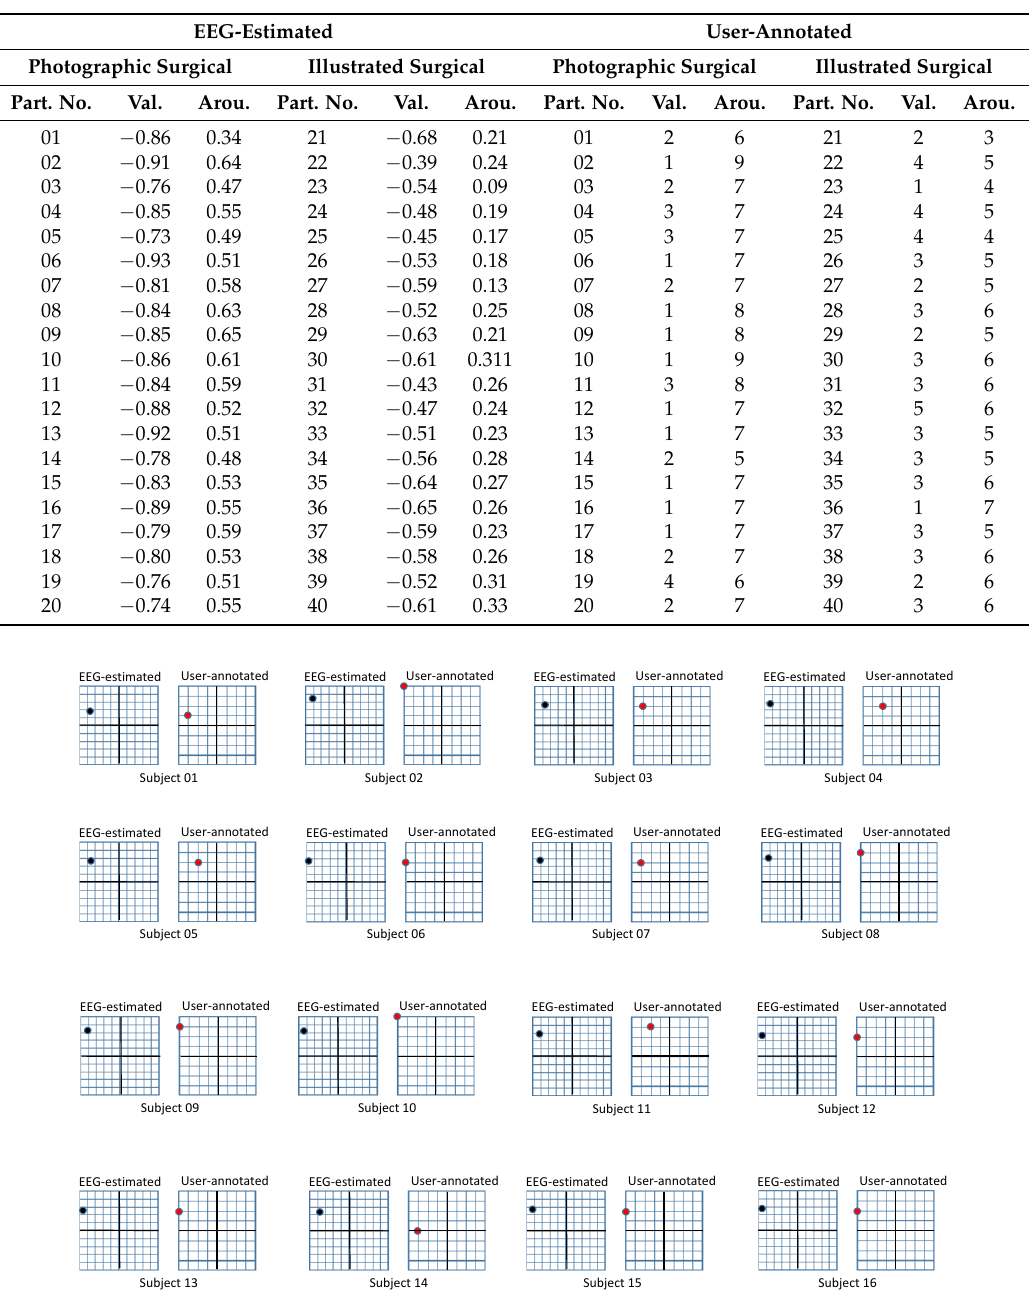
Table 2. Results of our experiment valence and arousal values in EEG-estimated matrix are rearranged to ( − 1 ∼ 1) scale. EEG-Estimated User-Annotated Photographic Surgical Illustrated Surgical Photographic Surgical Illustrated Surgical Part. No. Val. Arou. Part. No. Val. Arou. Part. No. Val. Arou. Part. No. Val. Arou.